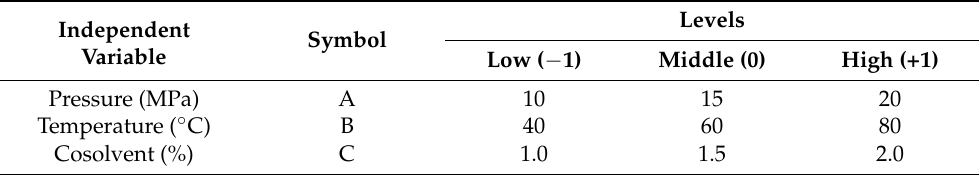
Table 4. Coded and real levels of independent variables for the designed